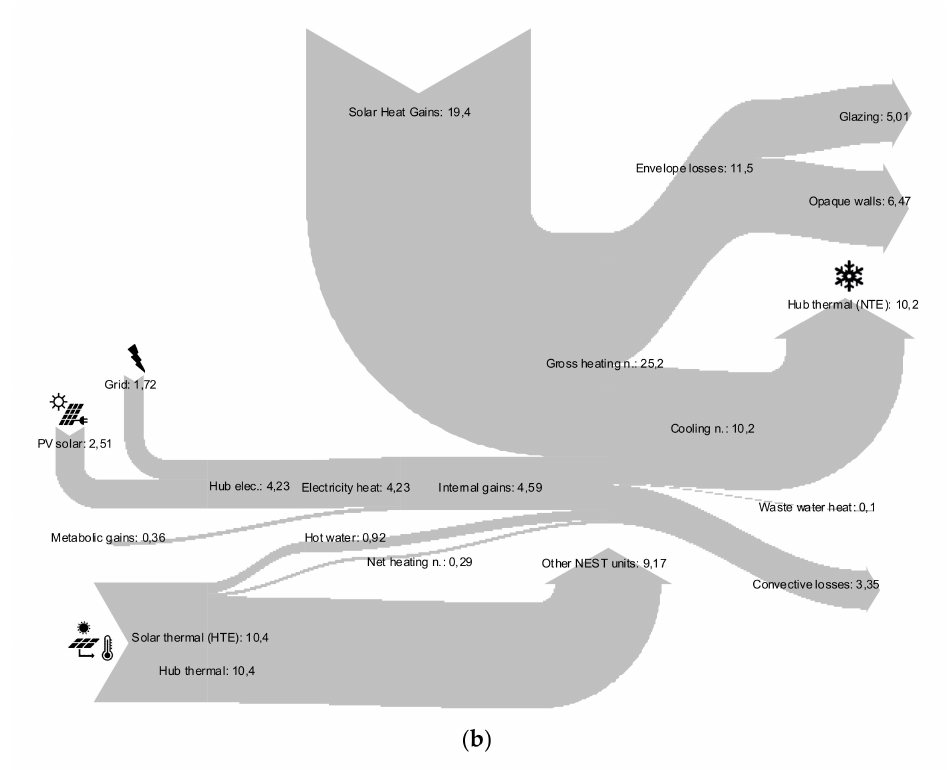
Figure 5. Sankey diagrams of the simulated ( a ) vs. monitored ( b ) scenario for the cooling season